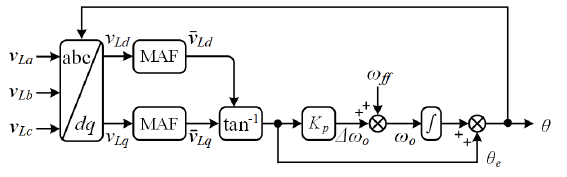
Figure 5. Block diagram of the quasi-type1-PLL algorithm.